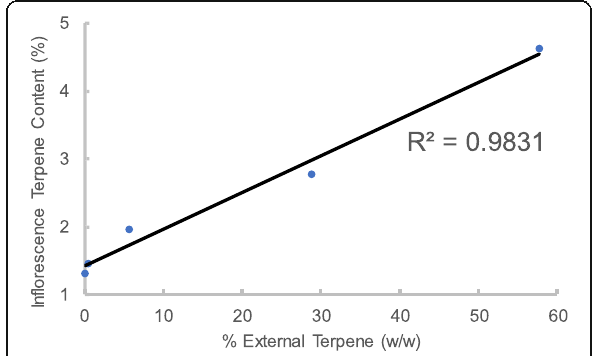
Fig. 3 Terpene content of preservation samples versus amount of external terpene. Linear best fit line and coefficient of determination (R 2 ) are